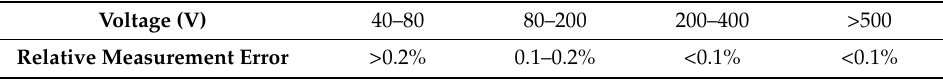
Figure 9. Digital output and relative measurement error of OVSs under voltage 500 – 4000V. Table 1. The results of relative measurement error of